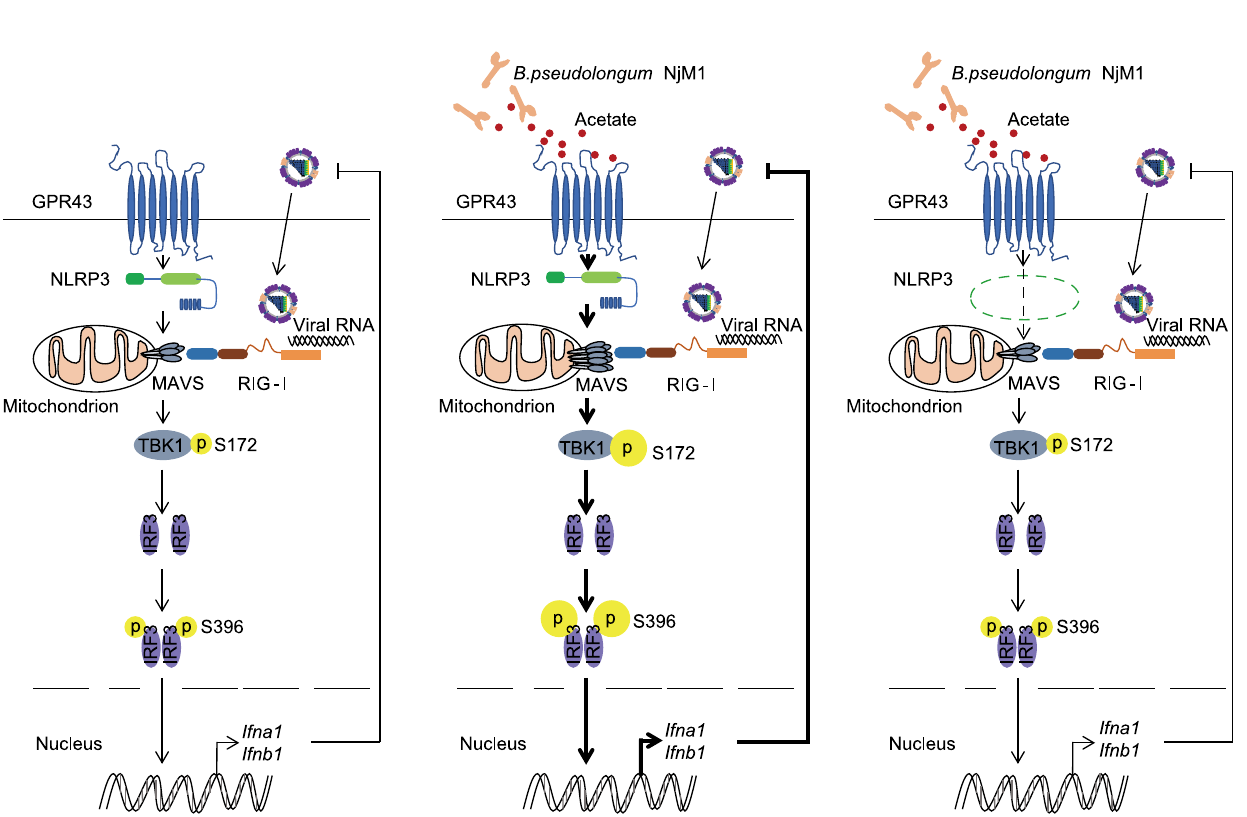
Fig. 8 | Proposed model for the role of NLRP3 in mediating acetate-enhanced induction of IFN-I. Recognition of in fl uenza viral RNA by RIG-I triggers MAVS aggregation,leadingtoIRF3phosphorylation(pIRF3)thatinitiatestypeIinterferon (IFN-I) production to contain the virus infection ( left ). B. pseudolongum NjM1 produces acetate that enhances viral RNA-triggered MAVS aggregation through